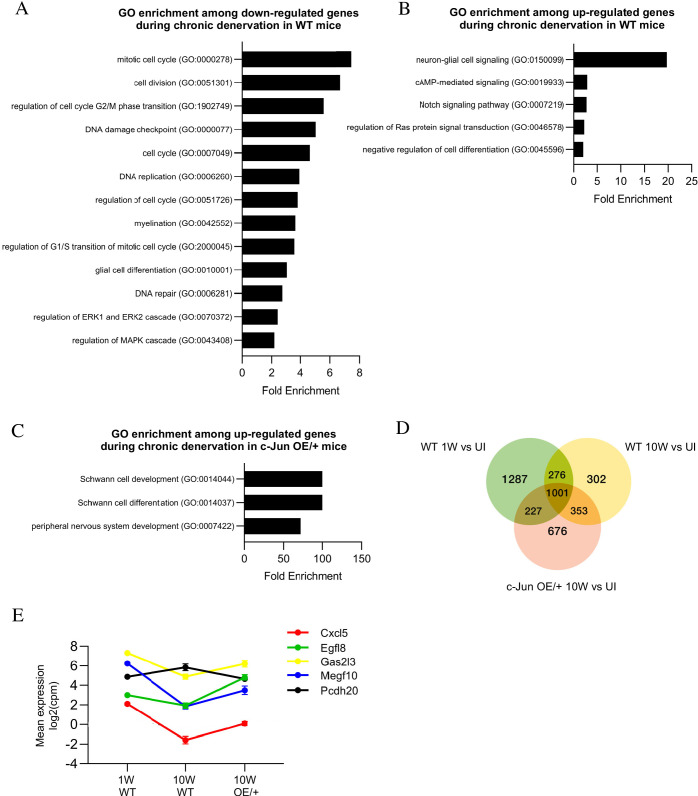
Bioinformatics analysis of RNA seq. data from acutely and chronically denervated nerves.(A) GO terms downregulated and (B) upregulated in WT nerves during chronic denervation. (C) When chronically denervated c-Jun OE/+ and WT nerves were compared, GO terms associated with Schwann cell differentiation (FDR = 0.00397) and PNS development (FDR = 0.0173) were enriched in c-Jun OE/+ nerves. (D) Venn diagram showing numbers of differentially expressed genes between WT nerves following acute (1 week) and chronic (10-week) denervation and c-Jun OE/+ nerves following chronic denervation, compared to their uninjured counterparts. (E) Mean expression of five c-Jun-regulated genes with significantly different expression between acute and chronic WT nerves, but not between acute WT and chronic c-Jun OE/+ nerves (absolute fold change >2 and FDR < 0.05).